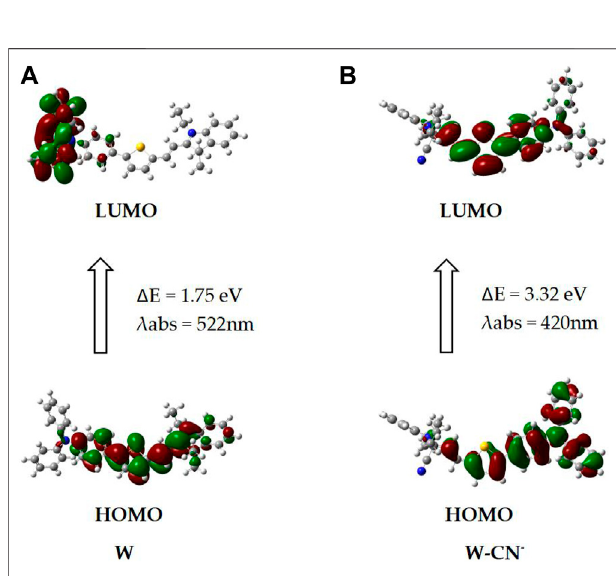
FIGURE 11 | DFT calculation of W and W – CN −